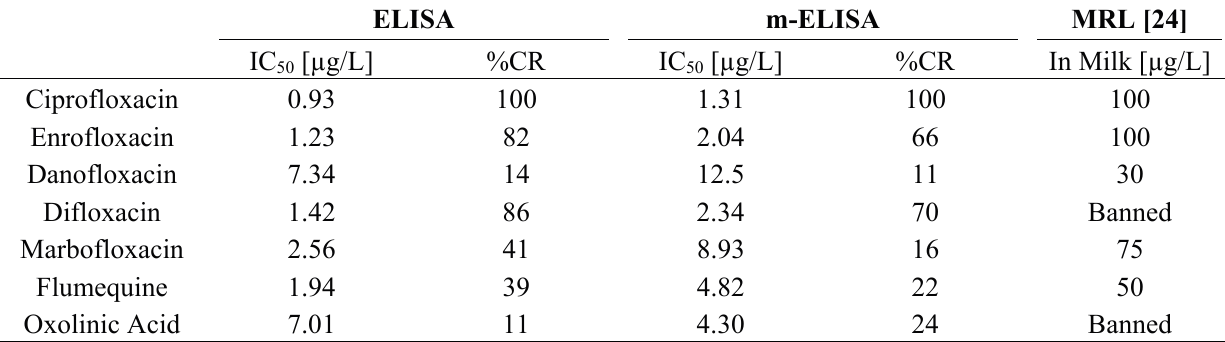
Table 3. Values of IC and cross-reactivity percentage of related fluoroquinolone 50 compounds in the ELISA and